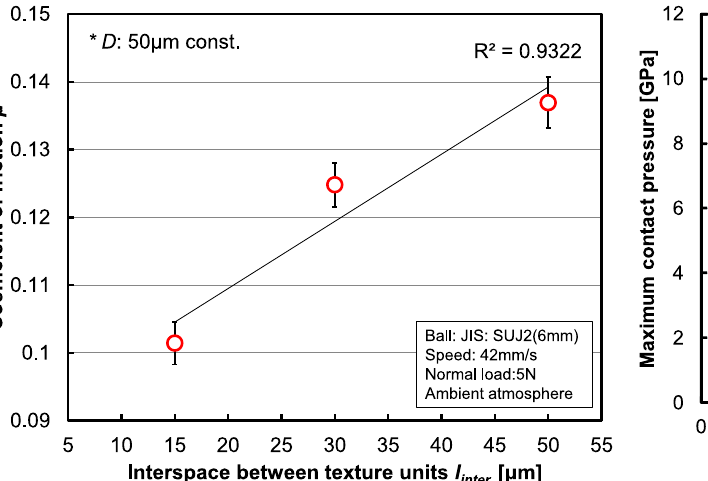
Fig. 9. Variations of averaged COF as a function of interspace between texture units of micro-textured DLC.